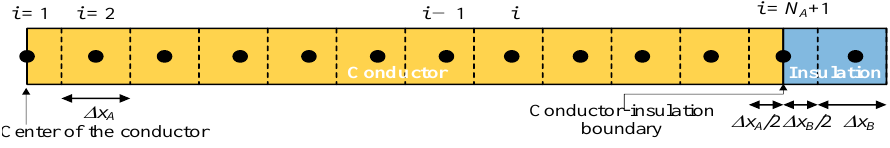
Figure 5. Conductor discretization. To properly distribute the electric current and the electric resistance along each divi- sion, the electric resistivity ρ e ( Ω ·m) and the current density J i = I i /S i (A/m 2 ) in each element are required, S i and I i being, respectively, the cross section and the current corresponding to the i -th element, so the resistance per unit length of the i -th element is r i = ρ e /S i ( Ω /m). First node ( i = 1) analysis. At the first node, heat is generated by the Joule effect and